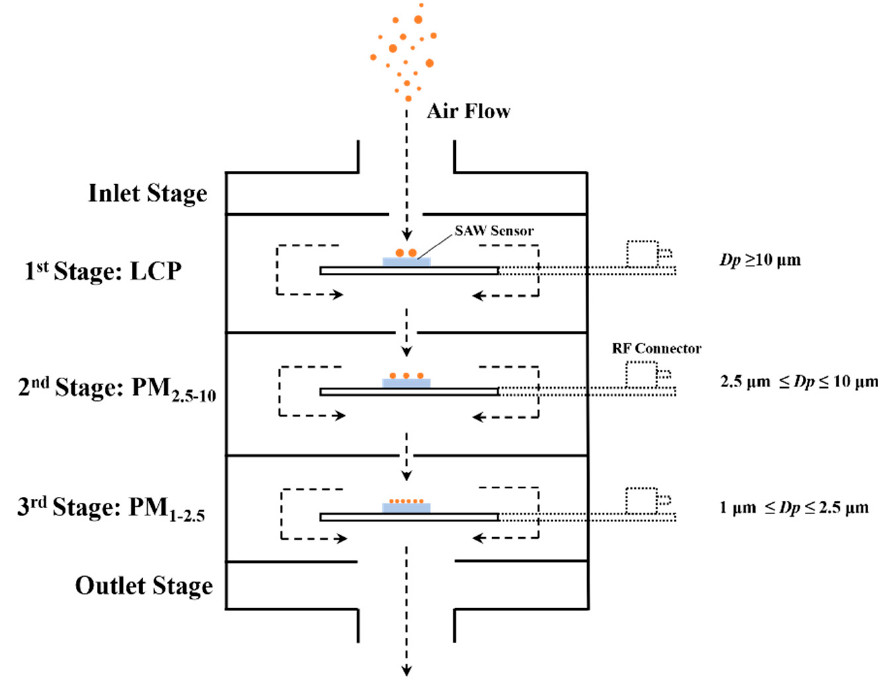
Figure 2. Schematic diagram of cascaded impactor with SAW sensors.